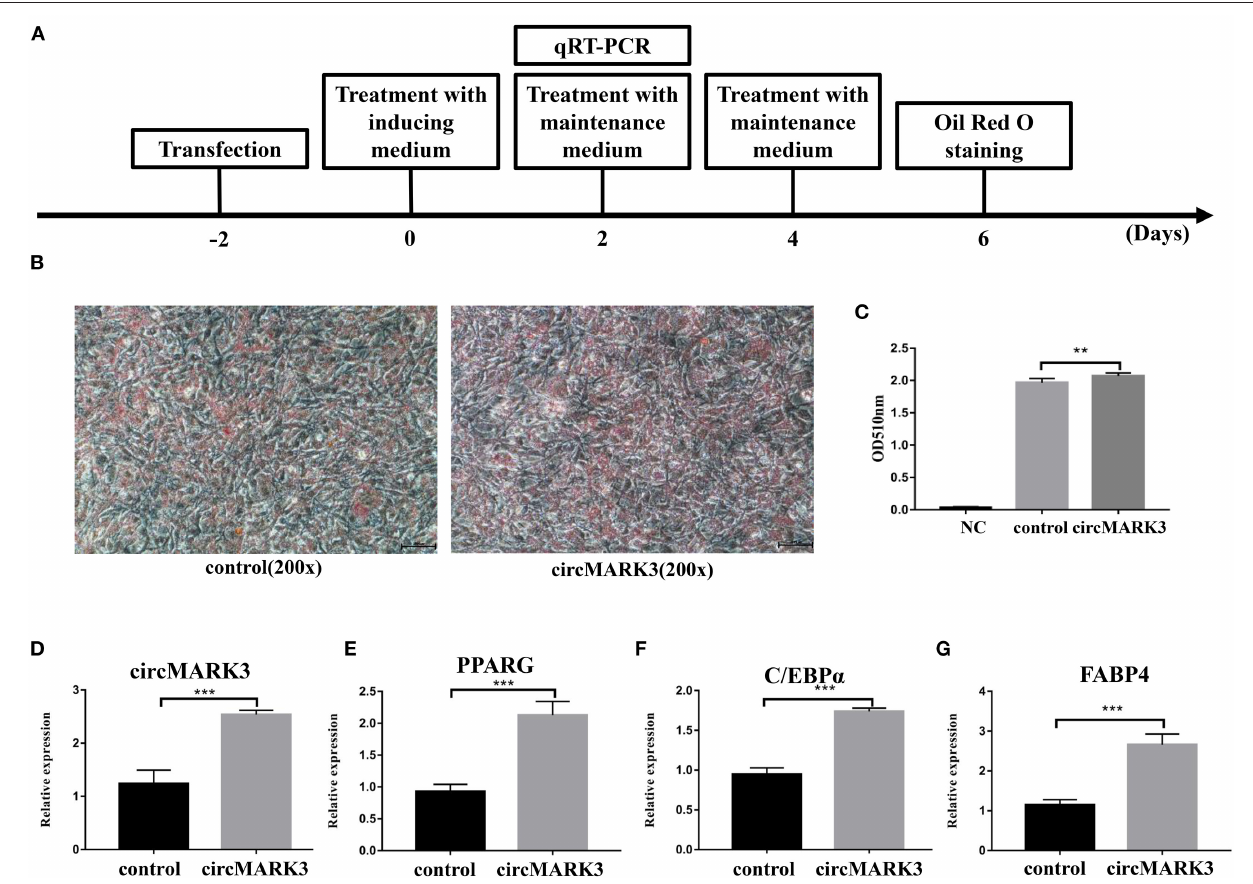
FIGURE 4 | Overexpression of mouse circMARK3 promotes adipogenic differentiation of 3T3-L1 adipocytes. (A) Strategy for mouse circMARK3 overexpression, adipogenic differentiation, RT-qPCR and Oil Red O staining in 3T3-L1 cells; (B) Oil Red O staining in 3T3-L1 cells transfected with pCD2.1-ciR and mouse pCD2.1-circMARK3 on day 6 after adipogenic differentiation. (C) Histogram corresponding to the quantification of Oil Red O staining by spectrophotometry; (D–G) RNA expression 48h after transfection of circMARK3 (D) , PPARG (E) , C/EBP α (F) and FABP 4 (G) . In panels (D–G) , mouse- β -actin was used to normalize the expression level of the reference gene in 3T3-L1 cells. Control means the pCD2.1-ciR group, circMARK3 means the mouse pCD2.1-circMARK3 group. NC means negative control. Data are presented as the mean ± SD, n = 3, ** P < 0.01, *** P <